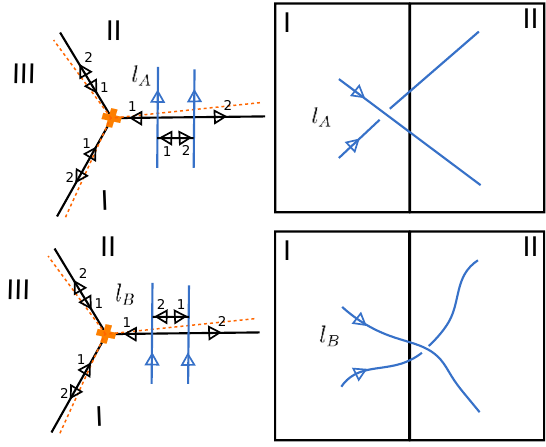
Figure 56 . The (cid:12)rst basic move in the neighborhood of a critical leaf.